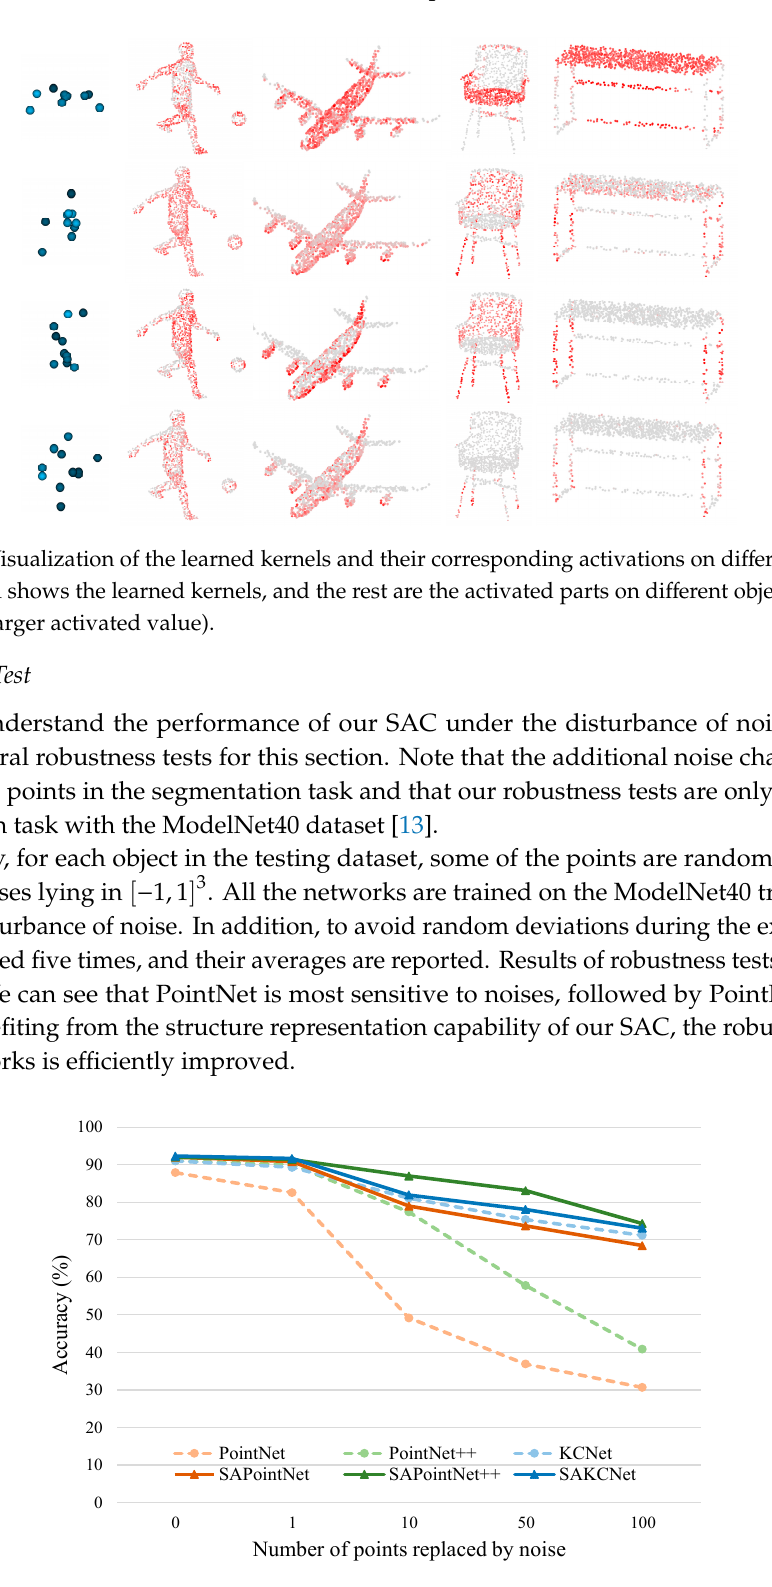
Figure 11. Robustness test of our proposed SAC under the disturbance of random